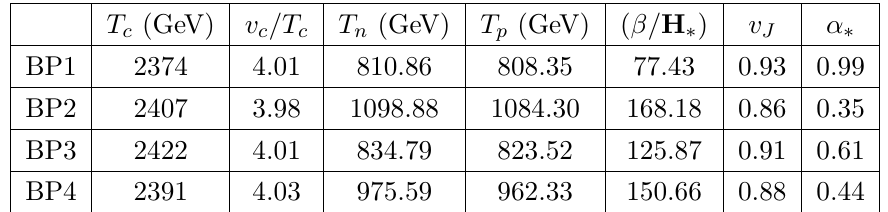
Table 2 . Benchmark parameters consistent with FOPT in conformal scotogenic model, along with the FOPT related parameters calculated for GW spectrum